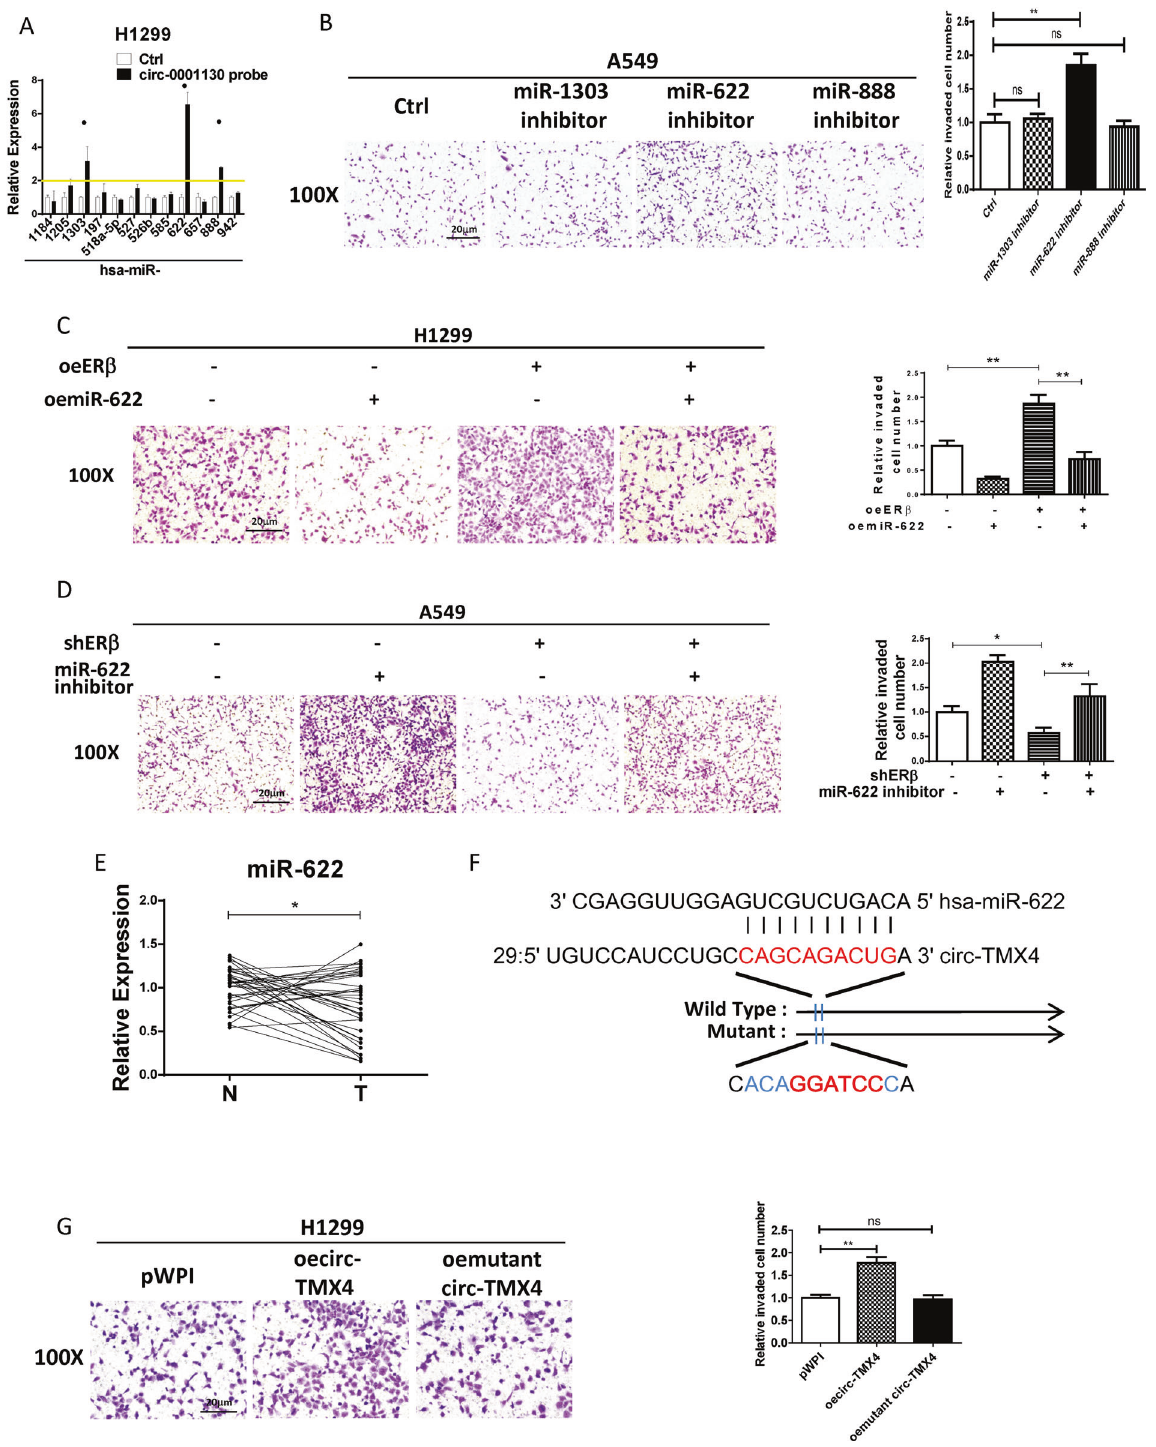
Fig. 4 Mechanism dissection of how ER β /circ-TMX4 signaling can increase lung cancer cell invasion: via altering the miR-622 expression. A RNA pull-down assay was applied to test whether circ-TMX4 could interact with 12 potential candidate miRNAs using the biotinylated oligonucleotide to target the circular junction of circ-TMX4. B Chamber-transwell invasion assay was used to check the invasion capacity after using miR-1303 inhibitor, miR-622 inhibitor and miR-888 inhibitor. C , D Chamber-transwell invasion assay was used to check the invasion capacity in H1299 ( C ) cells transfected with oeER β or oemiR-622 and in A549 ( D ) cells transfected with shER β or miR-622 inhibitor. E The expression of miR-622 in fresh lung cancer tumor tissues (T) and paratumor normal tissues (N) was detected by qRT – PCR. F The wild-type and mutant oecirc-TMX4 constructs. G Chamber-transwell invasion assays showed the ef fi ciency of wild-type and mutant oecirc-TMX4 in H1299 cells. All quantitations are presented as mean ± SD and p values calculated by t -test, * p < 0.05, ** p < 0.01, ns = not signi fi cant.